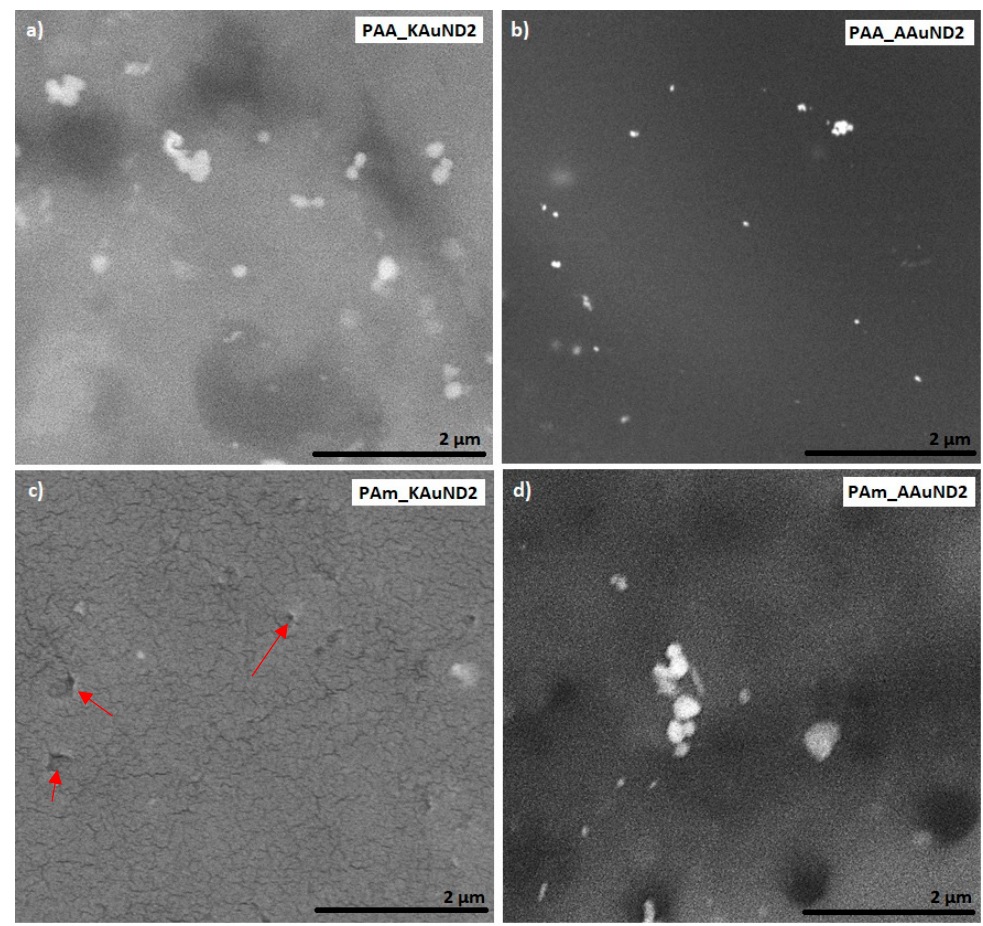
Figure 6. SEM images of prepared polyacrylate-AuNPs’ composites with AuNPs from gold acetate: ( a ) PAA_KAuND2; ( b ) PAA_AAuND2; ( c ) PAm_KAuND2 and ( d ) PAm_AAuND2. The arrows